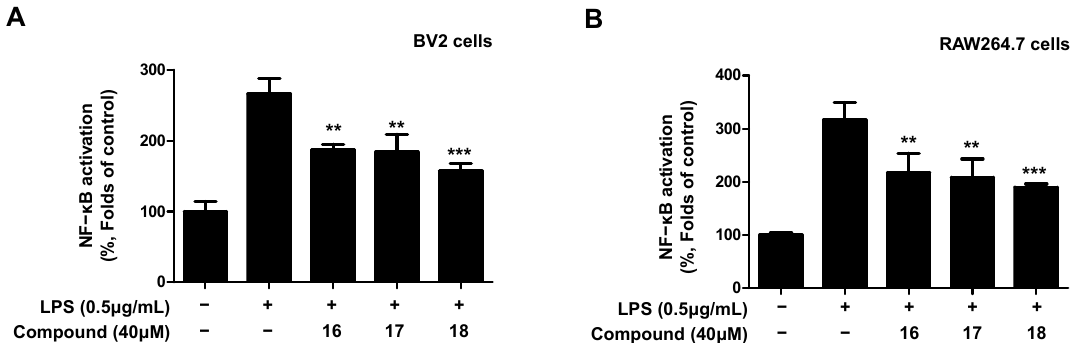
Figure 8. Inhibitory effect of compounds 16 – 18 on nuclear NF- κ B activation in LPS-induced BV2 microglia ( A ) and RAW264.7 macrophages ( B ). The inhibitory effect on NF- κ B activation in BV2 and RAW264.7 cells was induced for 18 h by treatment with LPS after pretreatment with 40 µ M of the compounds. Data are presented as the mean ± standard deviation values of three independent experiments. ** p < 0.01, *** p < 0.001 vs. LPS.